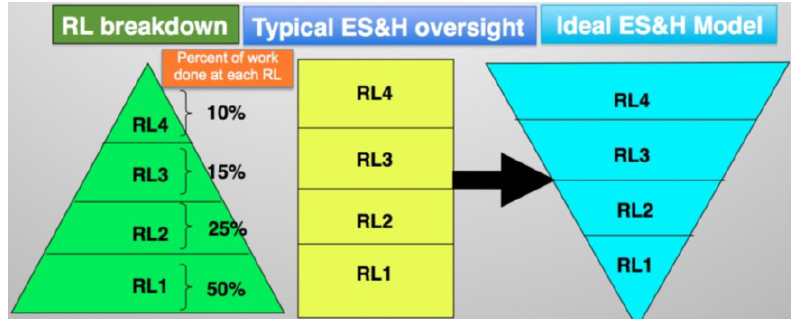
Figure 2. Risk level approach to EA oversight vs. current EA